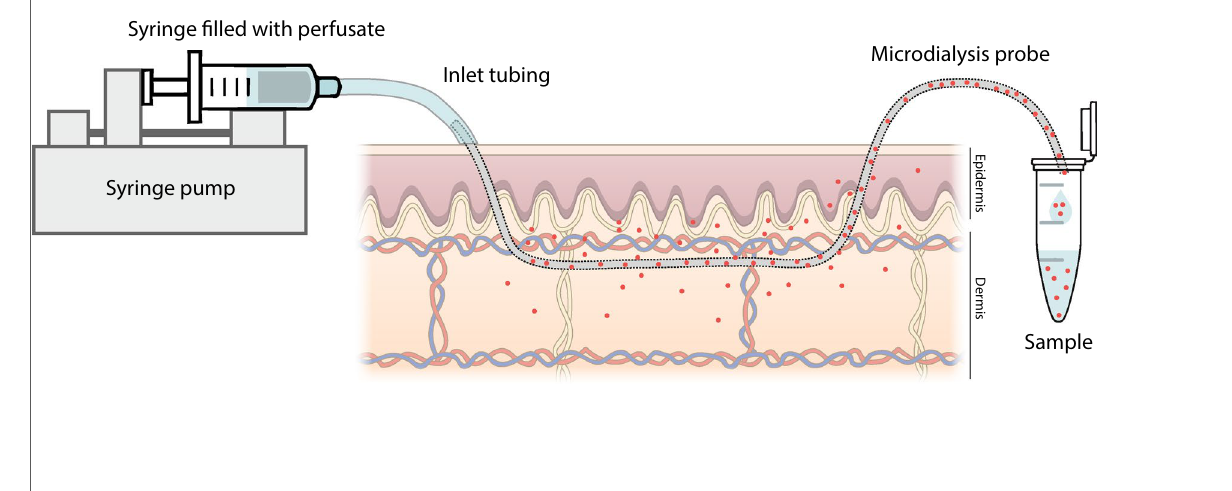
Fig. 1 Schematic representation of SMD (here with a linear microdialysis probe). The membrane is inserted into the tissue from which it allows recovery of soluble molecules (in red) when perfused using a microperfusion pump. © Niels Peter Hell